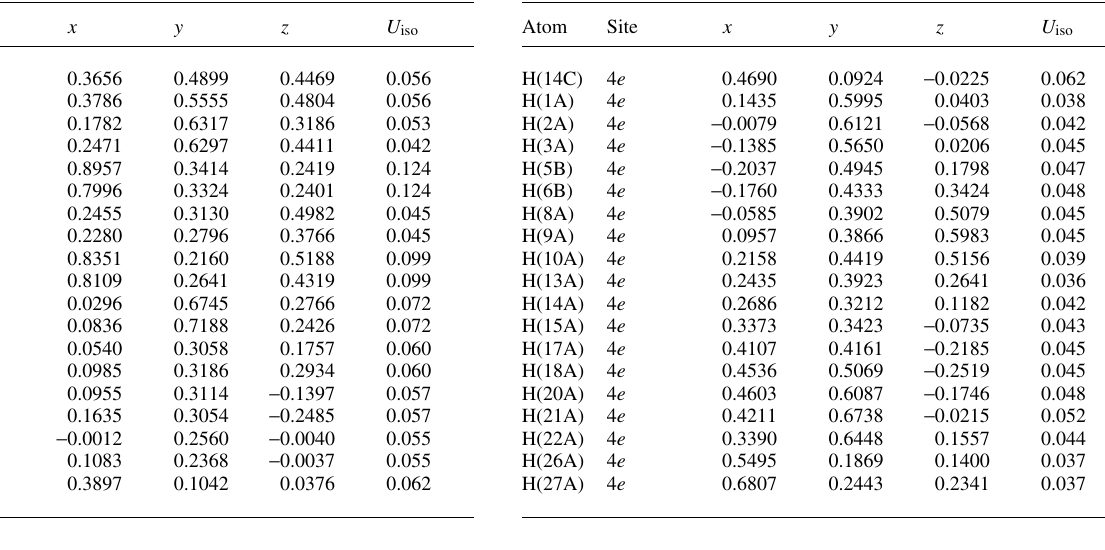
Table 2. Atomic coordinates and displacement parameters (in Å 2 )